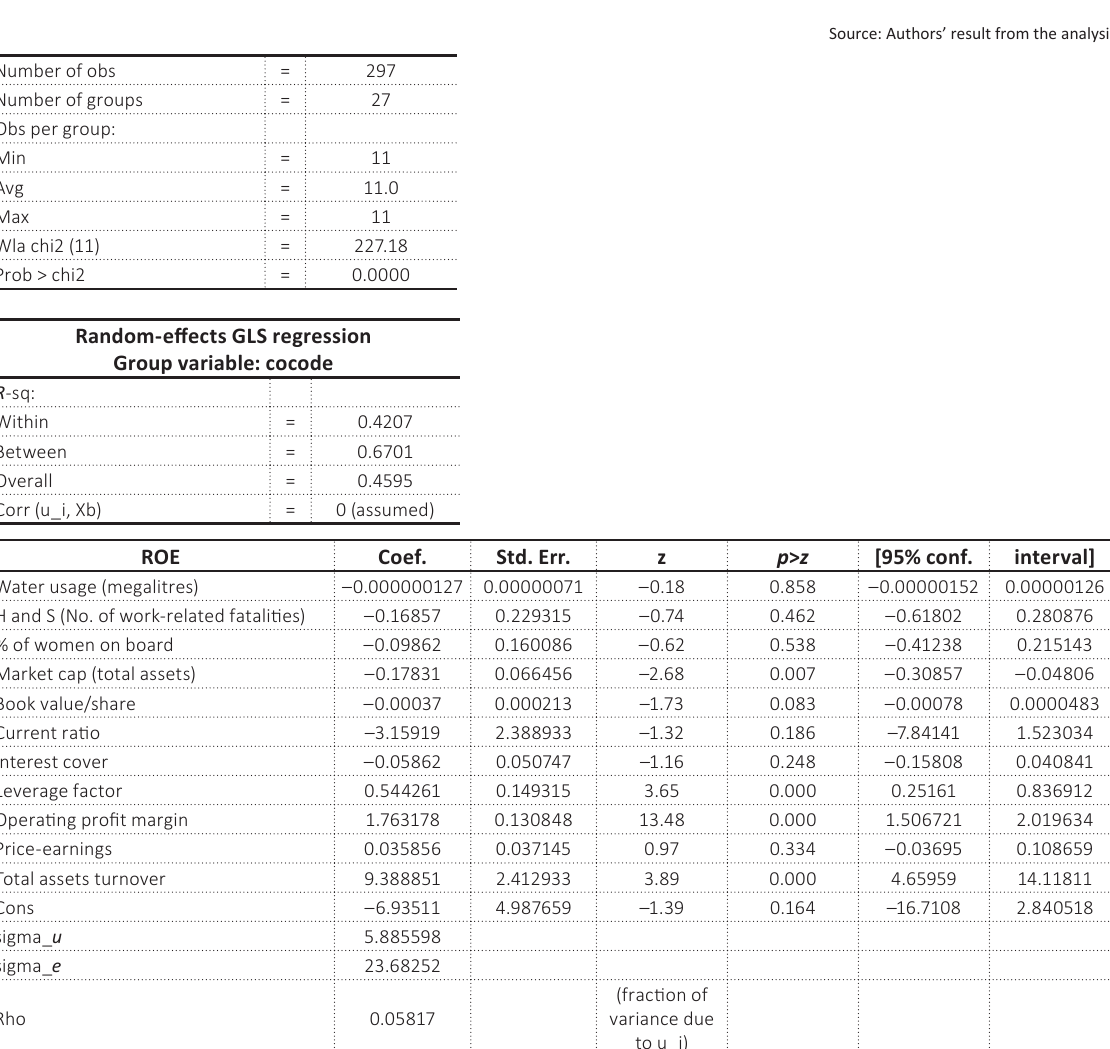
Table 5. Random-effects